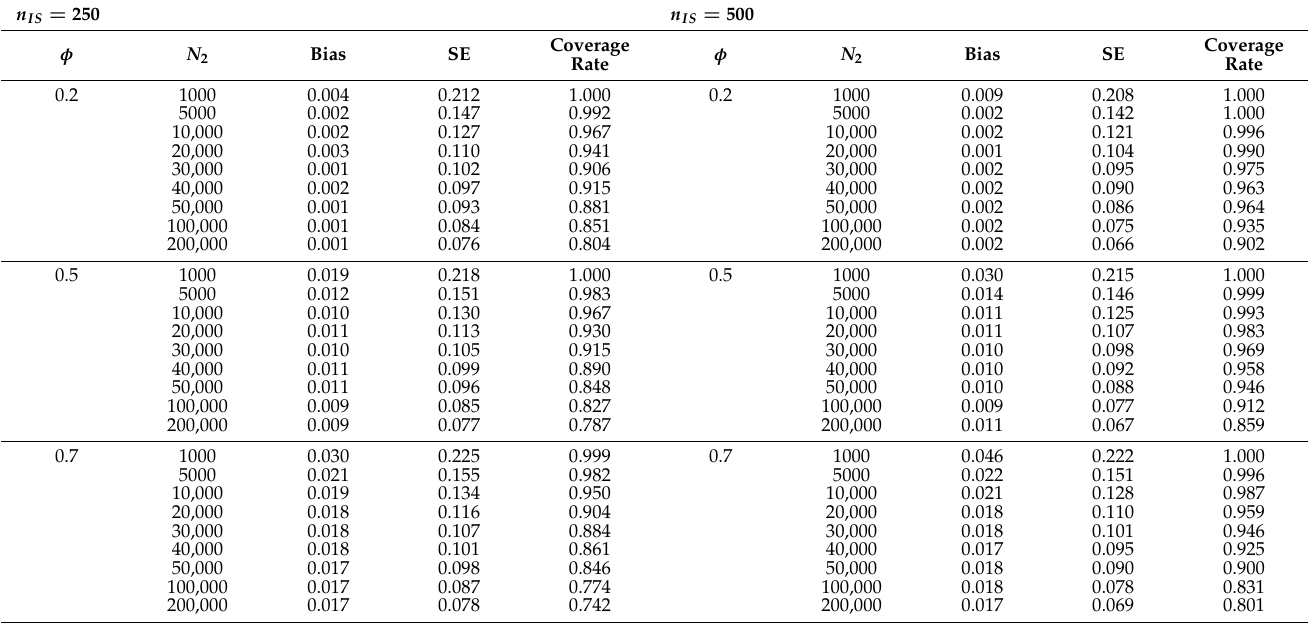
Table 3. Bias, standard errors, and coverage rate of the inverse sampling estimates of the proportion, according to the bias, dataset size, and extracted subsample